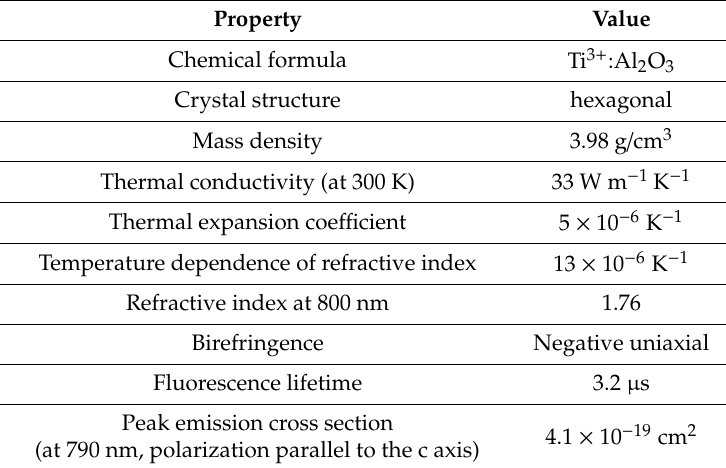
Table 2. The properties of Ti 3 + :sapphire crystals.